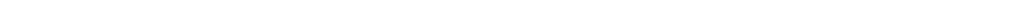
(see fi gure on previous page) Fig. 3 FadA inhibits host immune responses. a qPCR analysis of Il6 mRNA from peritoneal macrophages infected with H37Rv, H37Rv Δ FadA, or H37Rv( Δ FadA + FadA) strains for 4 h (MOI = 1) (mean ± SEM). b qPCR analysis of Il6 mRNA from adult zebra fi sh intraperitoneally infected with roughly 200 CFU per fi sh of WT, Δ FadA, or Δ FadA + FadA M. marinum strains for 14 days (mean ± SEM of n = 5). c qPCR analysis of Il6 mRNA from il6 + / + and il6 − / − zebra fi sh (mean± SEM). The Cas9/gRNA system was employed to generate IL-6 knockout zebra fi sh, which were constructed at the China Zebra fi sh Resource Center (CZRC) as described previously. d – g il6 + / + and il6 − / − mutant adult zebra fi sh were intraperitoneally infected with approximately 200 CFU of WT, Δ FadA, or Δ FadA + FadA M. marinum strains for 14 days. Bacterial titers ( d ; mean ± SEM of n = 5 fi sh infected for 14 days), histopathology ( e ; representative of one experiment with at least three independent replicates; scale bar, 100 μ m (top) and 20 μ m (bottom)), and comparison of granulomas between WT, Δ FadA, or Δ FadA + FadA M. marinum -infected il6 + / + and il6 − / − adult zebra fi sh scored for M. marinum burden as less than 10 or 10 or more bacteria ( f ) or percentage of necrotic granulomas in each fi sh ( g ) were assessed as described previously. “ n ” was the total number of granulomas for each strain infected fi sh. Total number of zebra fi sh analyzed: fi ve (WT/ il6 + / + ), fi ve ( Δ FadA/ il6 + / + ), fi ve ( Δ FadA + FadA/ il6 + / + ), fi ve (WT/ il6 − / − ), fi ve ( Δ FadA/ il6 − / − ), fi ve ( Δ FadA + FadA/ il6 − / − ). Data in a – g represent one experiment with at least three independent replicates. One-way ANOVA with Bonferroni ’ s multiple comparisons test ( a , b , d ), two-tailed unpaired Student ’ s t- test ( c ) and Fisher ’ s exact test ( f , g ) were used for statistical analysis.